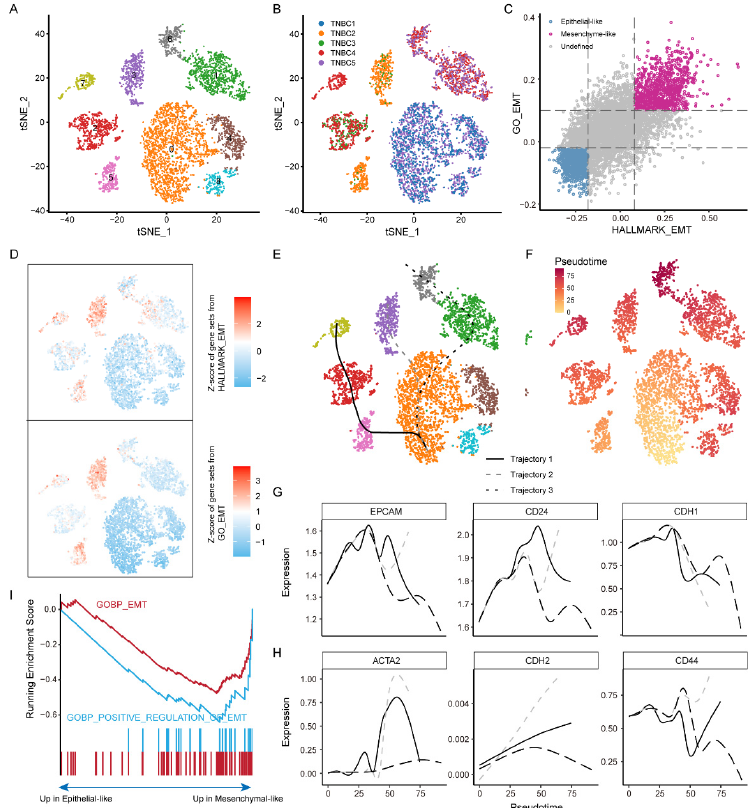
Figure 4. Subpopulations of malignant epithelial cells showing a transition from epithelium-like to mesenchyme-like. ( A , B ) t-SNE visualization of TNBC malignant cells. Clusters were annotated for ( A ) cell clusters and ( B ) cancer patients, respectively. ( C ) Scatter plot showing the epithelium-like (blue) and mesenchyme-like (pink) malignant cells. ( D ) The t-SNE map showing TNBC malignant cells was colored by the EMT-score. Color from blue to red reflects epithelial-like to mesenchymal-